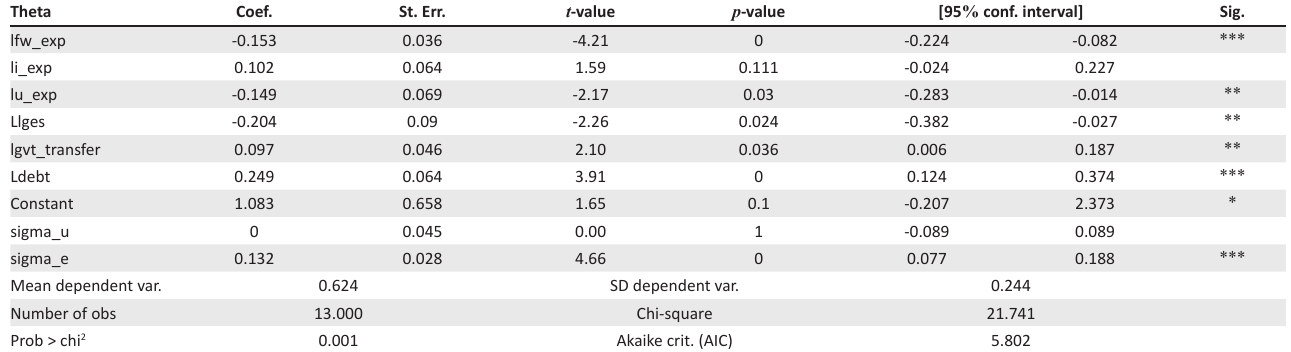
TABLE 5: Random effects tobit regression.